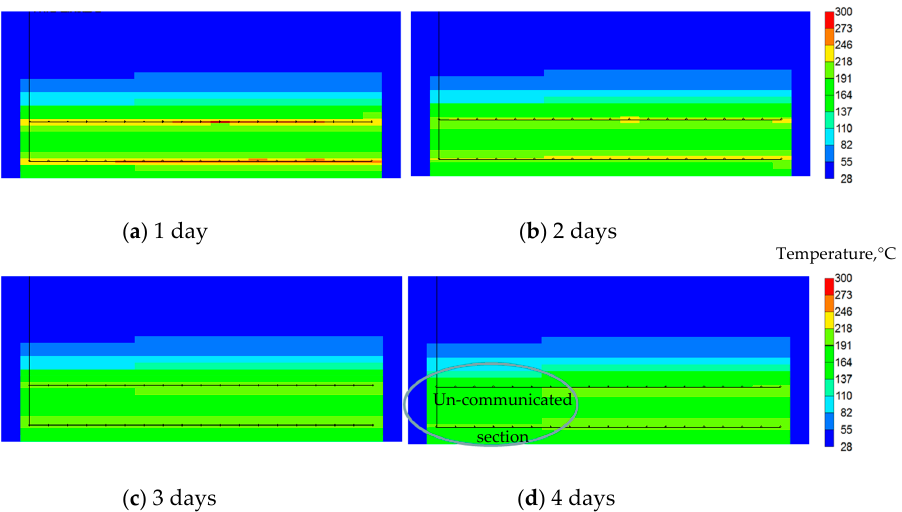
Figure 11. Temperature variance with different soak time (preheat for 180 days).